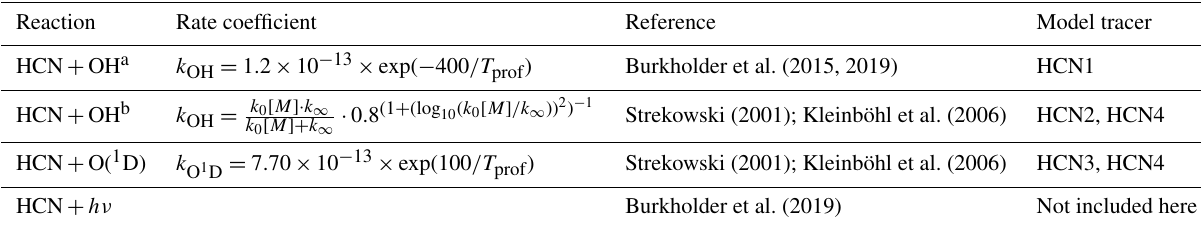
Table 2. HCN atmospheric photochemical loss mechanisms used for the different TOMCAT model tracers.